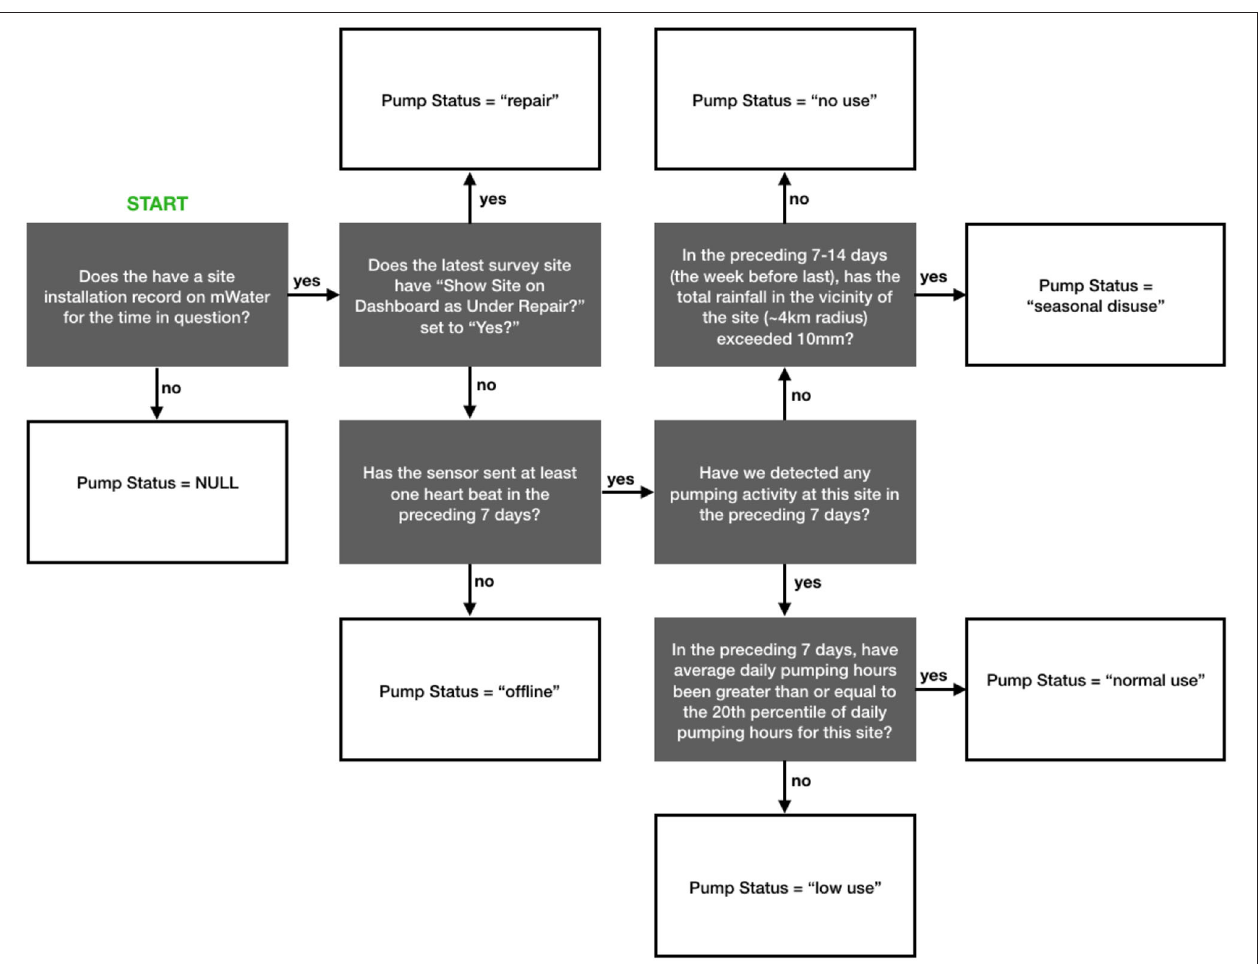
FIGURE 5 | Sensor data expert classification system